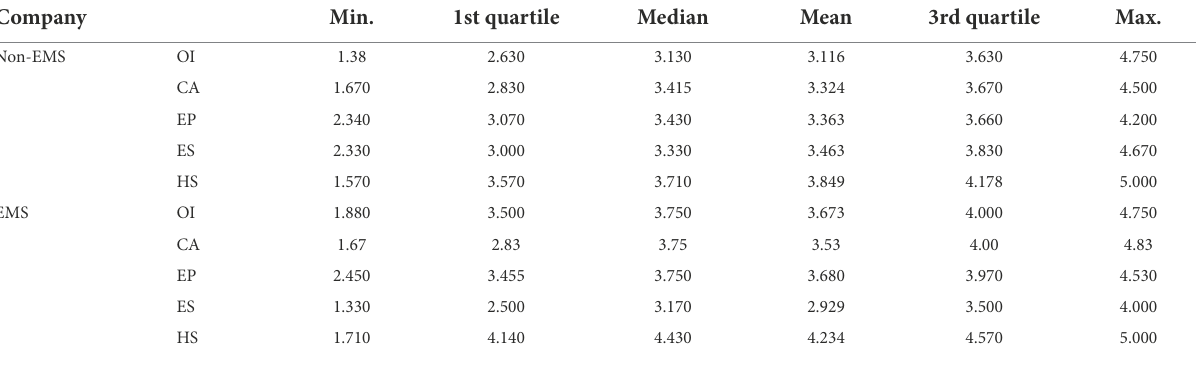
TABLE 4 Descriptive data